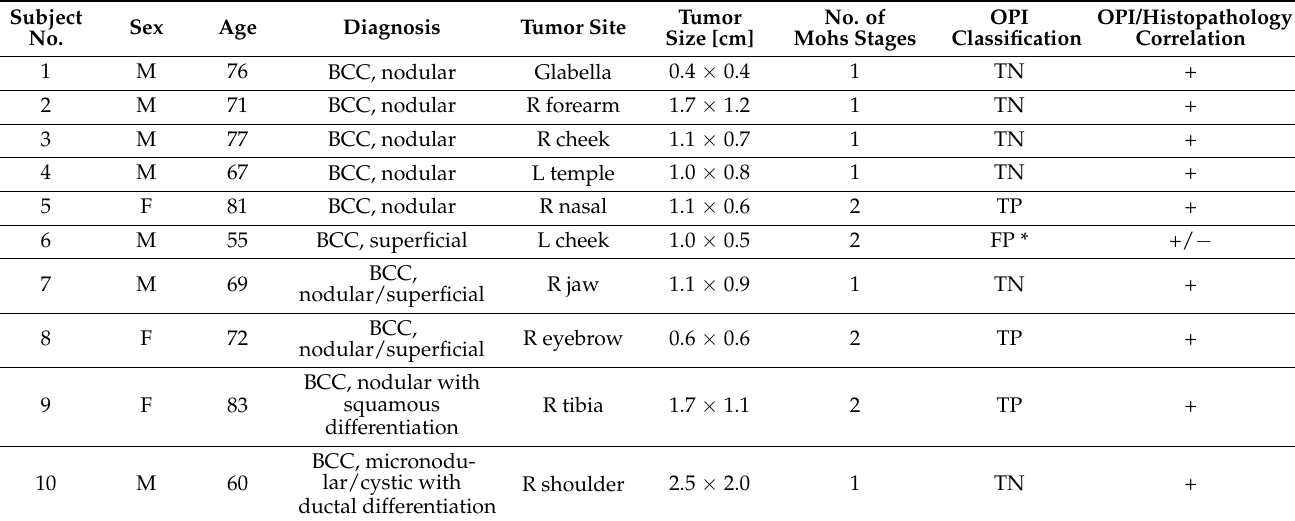
Table 2. Clinical information and experimental data for 10 study